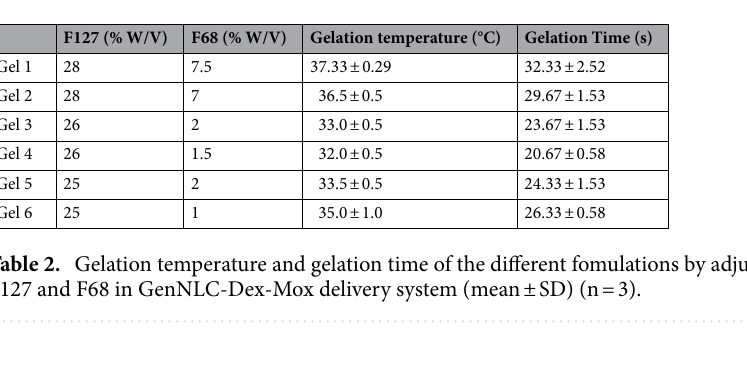
Figure 2. Physical appearance, sketch, transmittance and in vitro release profiles of the multi-drug delivery system containing dexamethasone (Dex), moxifloxacin (Mox) and genistein (Gen). ( a ) The hydrogel was light yellow, homogeneous and transparent in liquid phase. ( b ) The thermosensitive hydrogel presented in semi-liquid/semi-gel transition phase when it was heated up to 30 °C. ( c ) The hydrogel in gel phase when the temperature was above 33 °C. ( d ) Genistein was entrapped in nanostructured lipid carrier (GenNLC). Dex was combined with CaCl 2 . Mox was added directly into the hydrogel. ( e ) Within the range of 500–800 nm, the overall transmittance of the hydrogel (blue) was over 65% (66.88 ± 0.72% – 83.22 ± 1.87%). The transmittance in the range of 400 – 500 nm decreased to 0.05%. The transmittance of the solution with melting GenNLC-Dex- Mox hydrogel (purple) was 62.15 ± 0.12% at 400 nm, while the transmittance were all above 90% (93.44 ± 0.33% to 100%) at range of 430 nm to 800 nm. ( f ) Moxifloxacin showed a quick release for up to 10 days and 98.76 ± 2.31% of moxifloxacin molecules were released till day 9. Dexamethasone was released from hydrogel in the first week at a high but constant rate, then, the rest released sustainably until day 30 (97.14 ± 3.38%) with a tapering down rate. Genistein was released slowly but persistently with a decreasing rate as well. The cumulative release amount of genistein was 63.35 ± 2.49% at day 40.